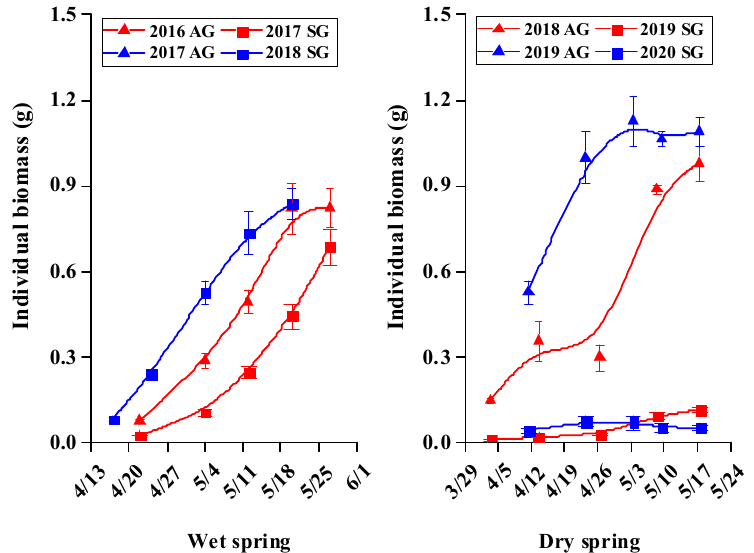
Figure 10. Increase in individual biomass of spring (SG)- and autumn (AG)- germinating plants of Erodium oxyrhinchum in wet ( left ) and dry ( right ) springs. The first three periods represent the veg- etative stage, and the last two periods represent the reproductive stage. Vertical bars indicate stand- ard errors of the means (n = 8).